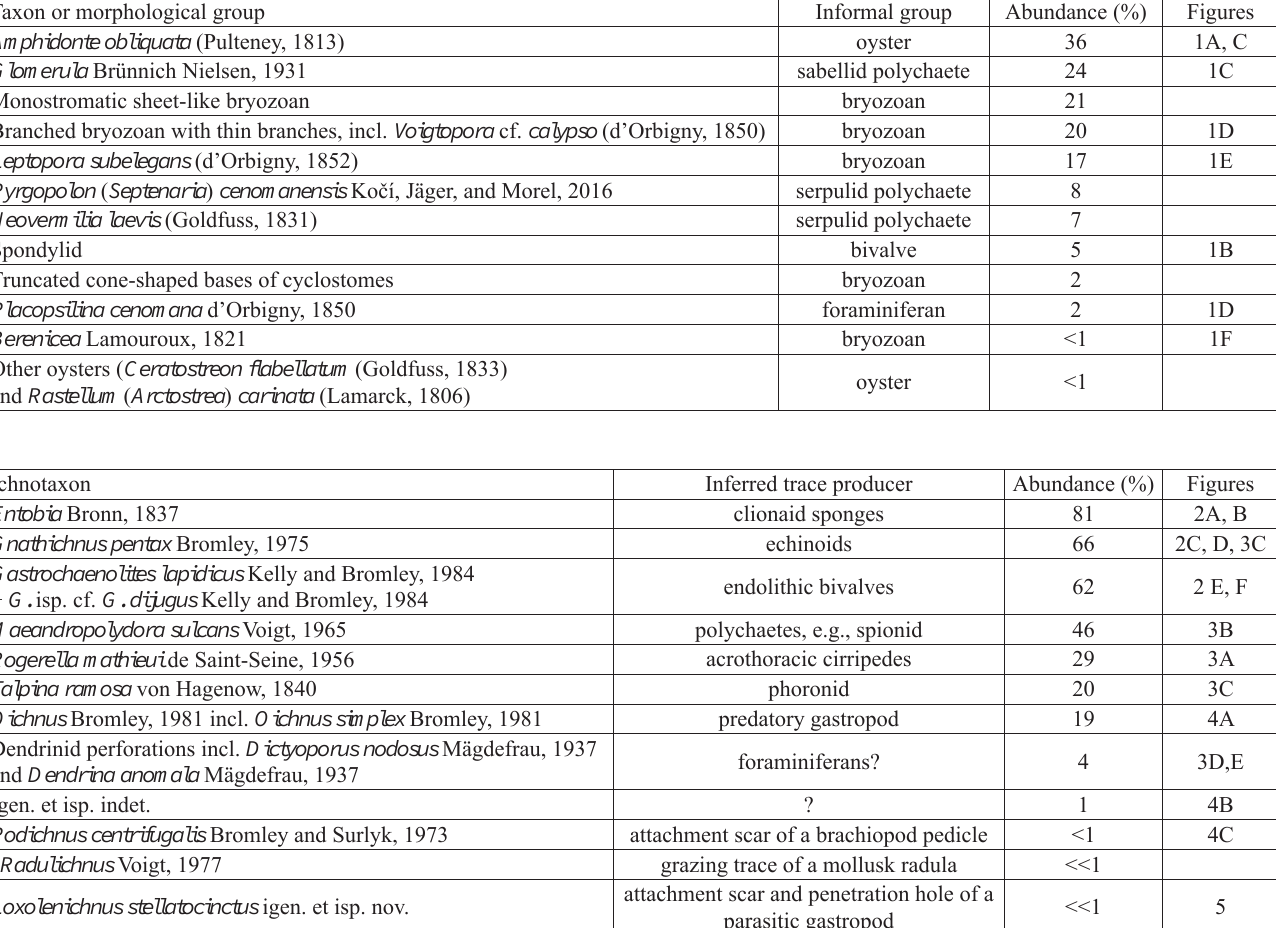
Table 1. Encrusters ( A ) and ichnotaxa ( B ) inventory, in order of decreasing relative abundance, recorded from a random sample of 234 oyster shells, collected in the Marnes à Pycnodonte biauriculata (Upper Cenomanian, Le Mans, France), with their known or inferred trace maker, and relative abundance. Percentages rounded to the nearest integer. Since no resin casts were available (see text), the list gives the ichnogenera when the ichnospecies are not recognizable. Likewise, most of the bryozoans are eroded, making their identification unsure, even at the generic level: they are divided into morphological